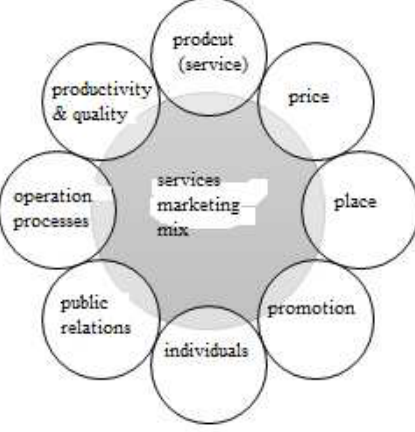
Fig. 1. Services marketing mix model (8P) (Lovelock & Wright,